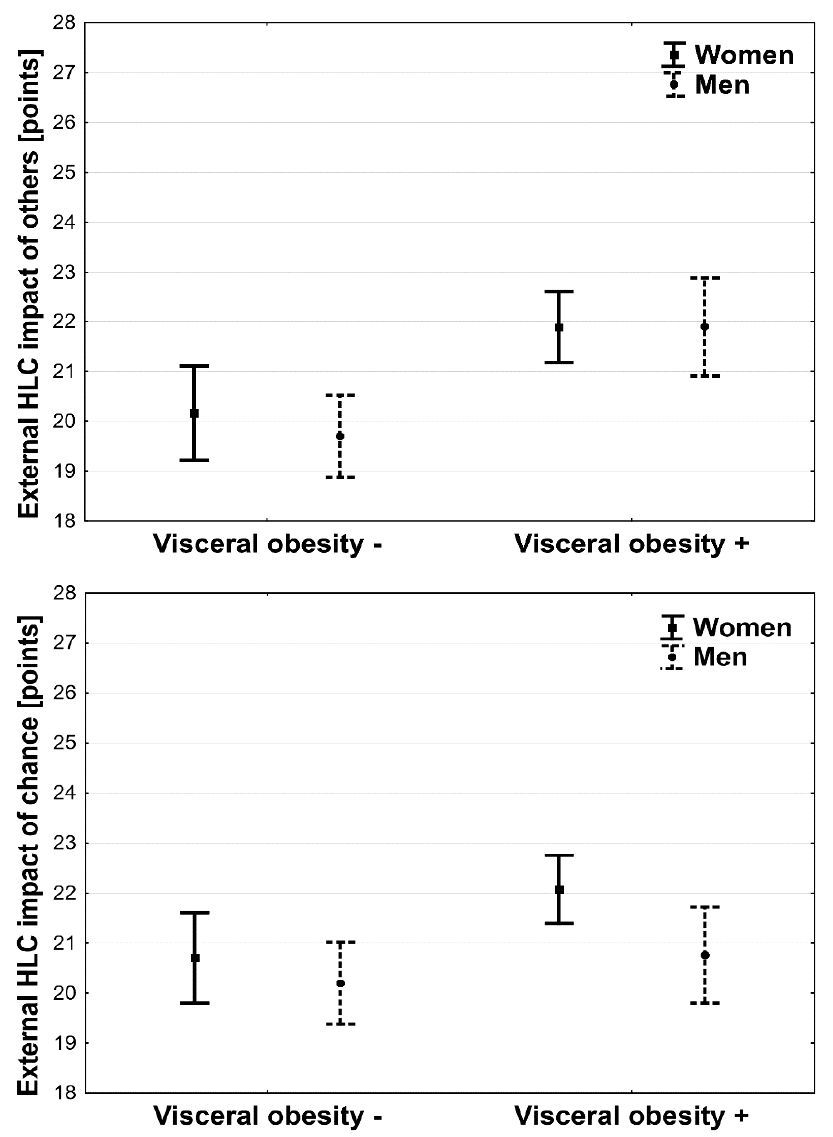
Figure 3. Health locus of control and sex and visceral obesity.